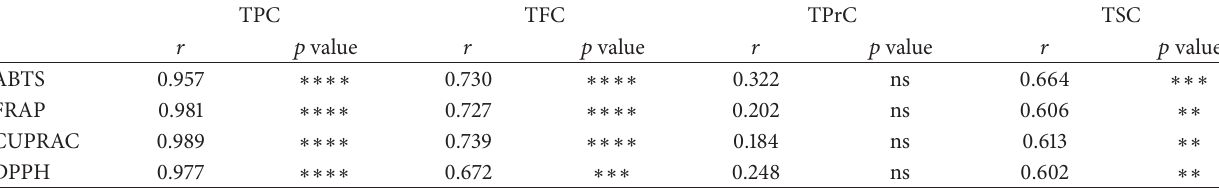
Table 2: Correlation between bioactive compounds and antioxidant properties of the root of S.